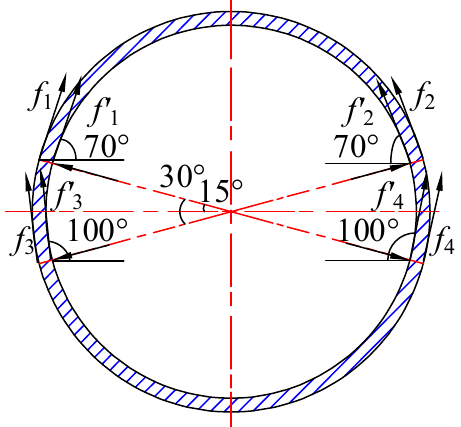
Figure 5. Direction and Action Point of Friction Clamping Force of Spreader.